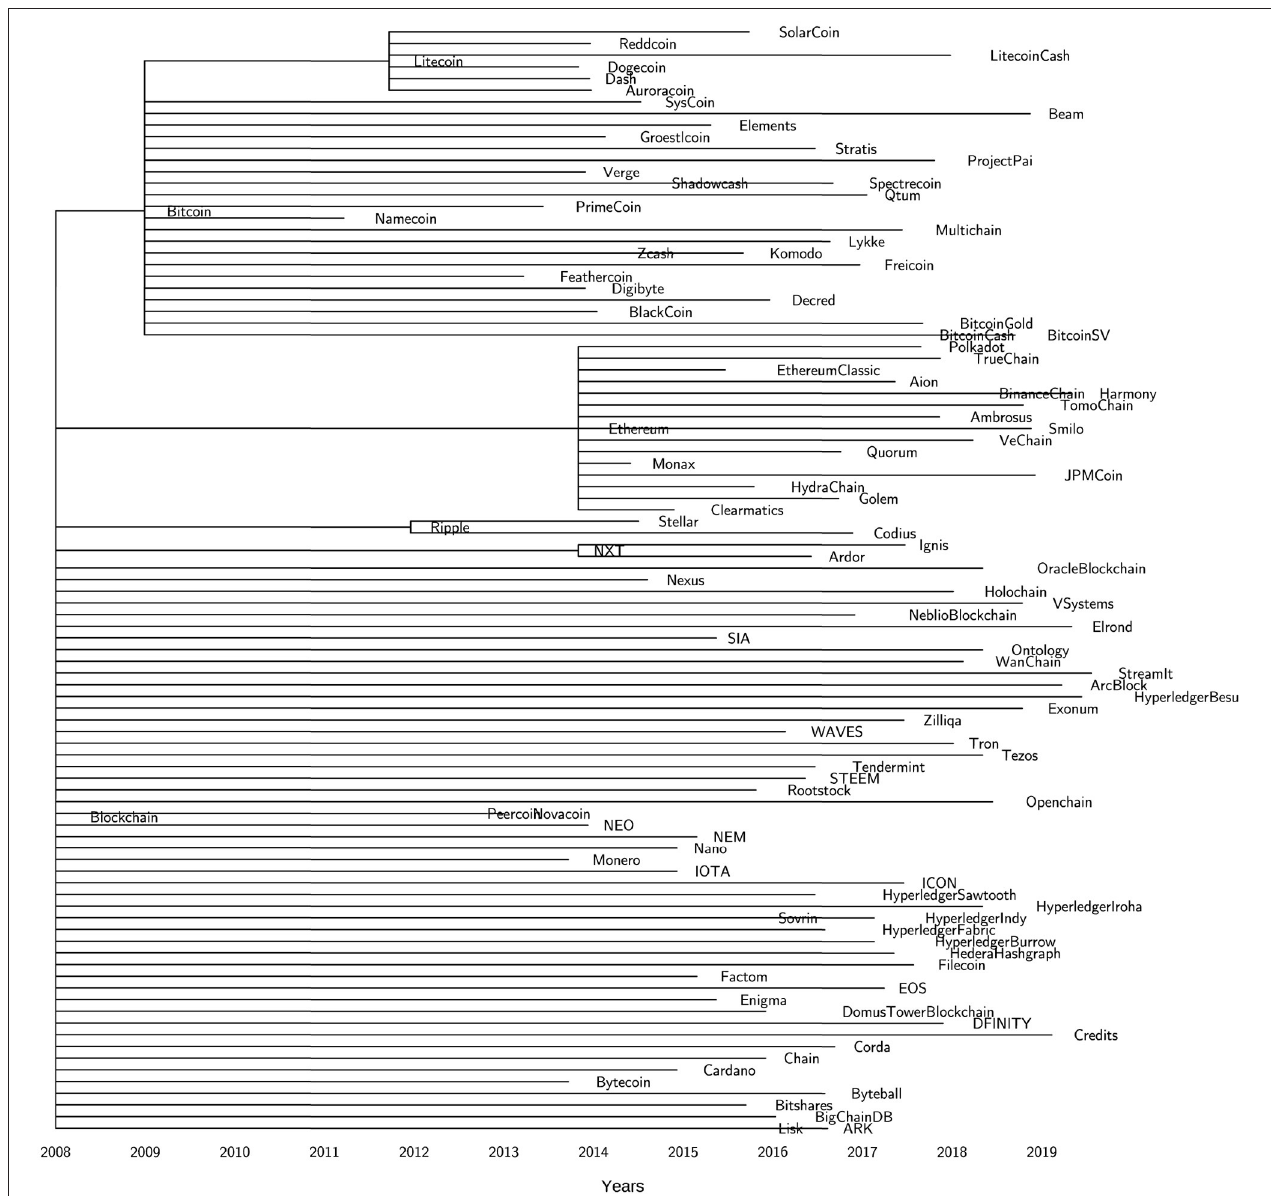
FIGURE 6 | The chronogram tree of the blockchain technologies.